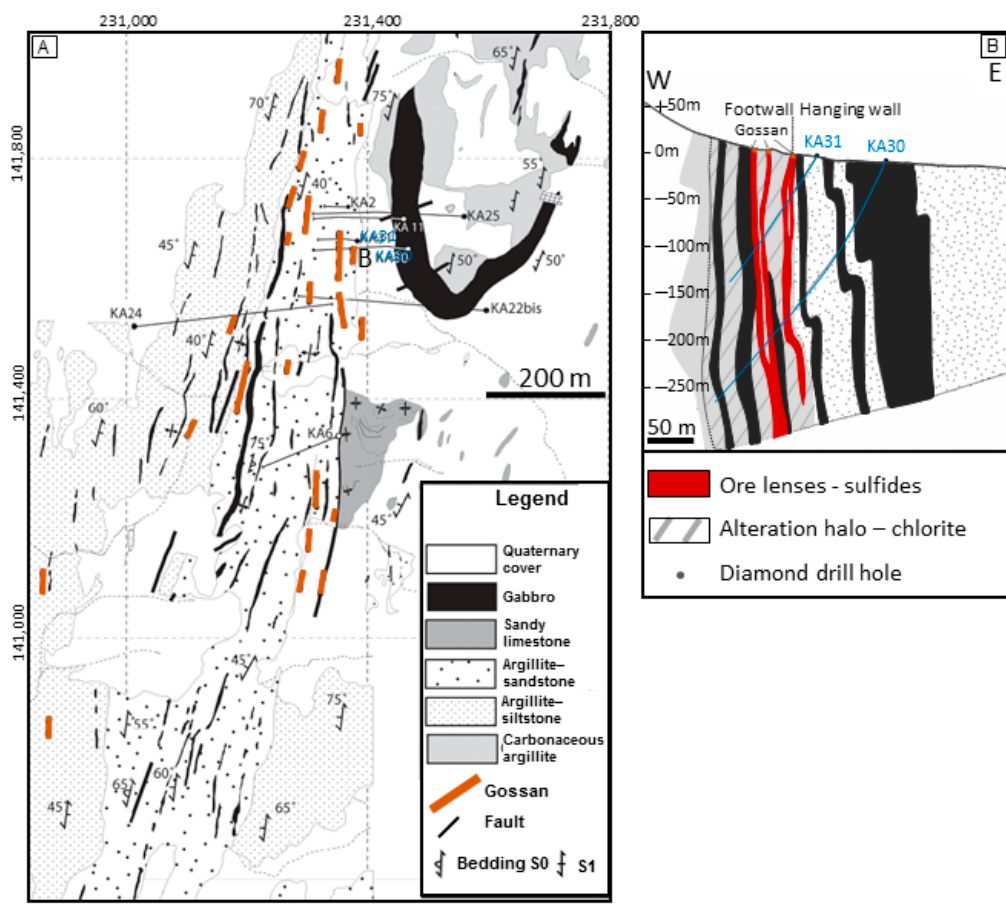
Figure 2. ( A ): Geological map of the Koudiat Aïcha area [17] (modified). ( B ): Cross section along two drillings, KA31 and KA32, cutting across the ore lenses [17] (modified); see ( A ) for drilling locations.